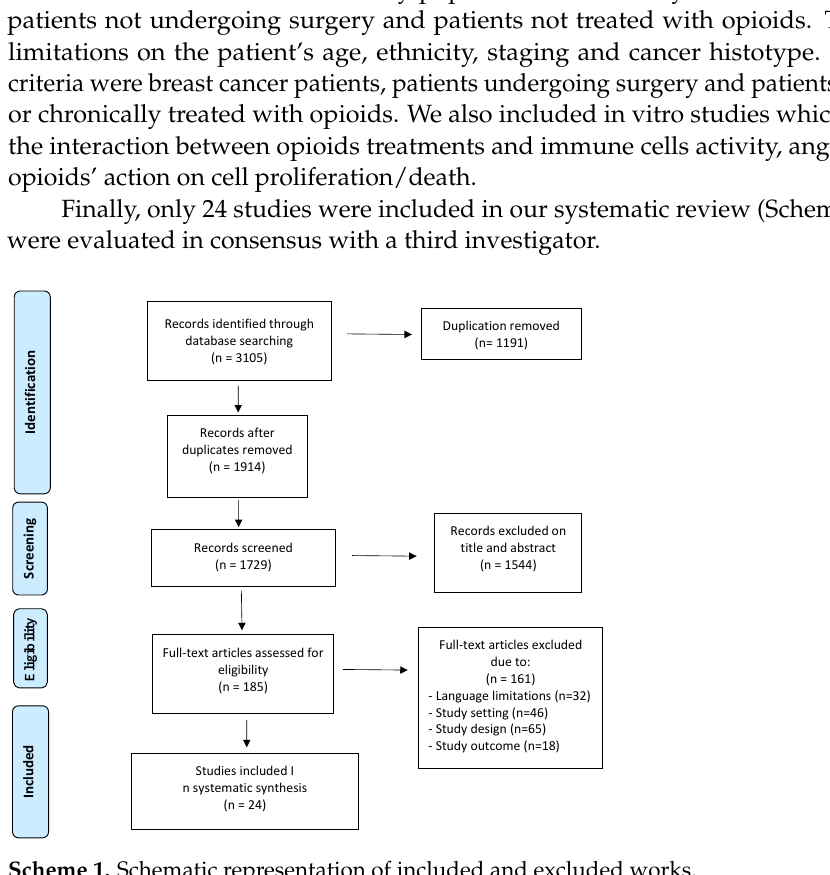
Scheme 1. Schematic representation of included and excluded Table 1. Opioids and immune system. Selected preclinical studies. NKCC: natural killer cell cytotoxicity; NK: natural killer; IL-2: interleukin-2; PVA: paravertebral anesthesia; ER: estrogen receptor.